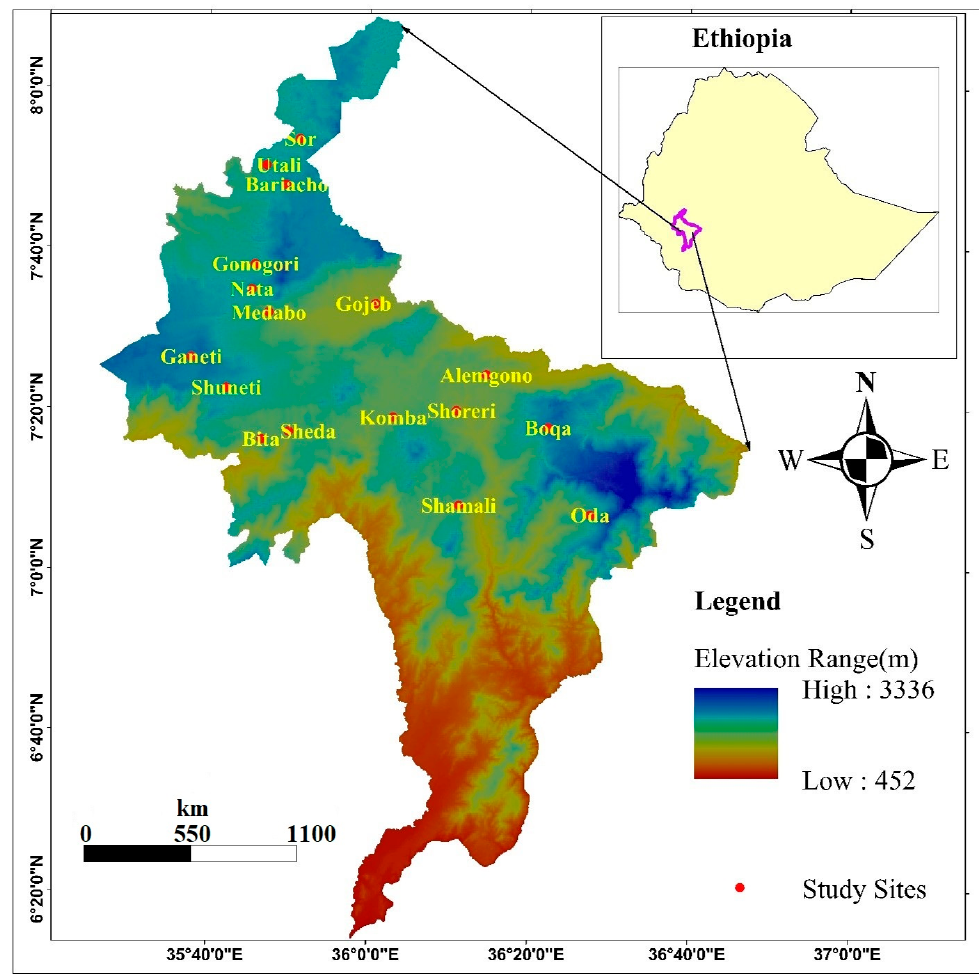
Figure 1. Map of the study